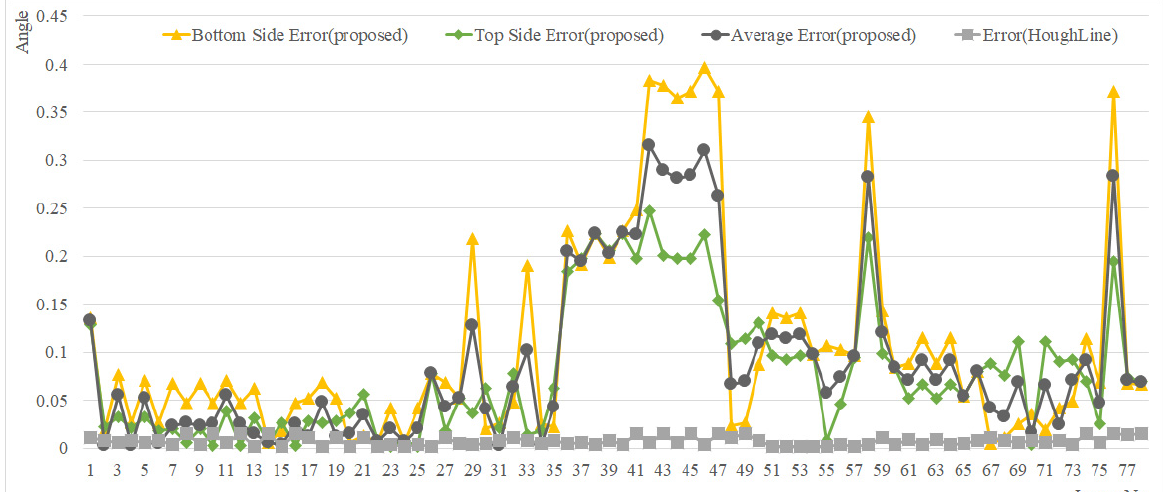
Figure 22. Angle measurement results.